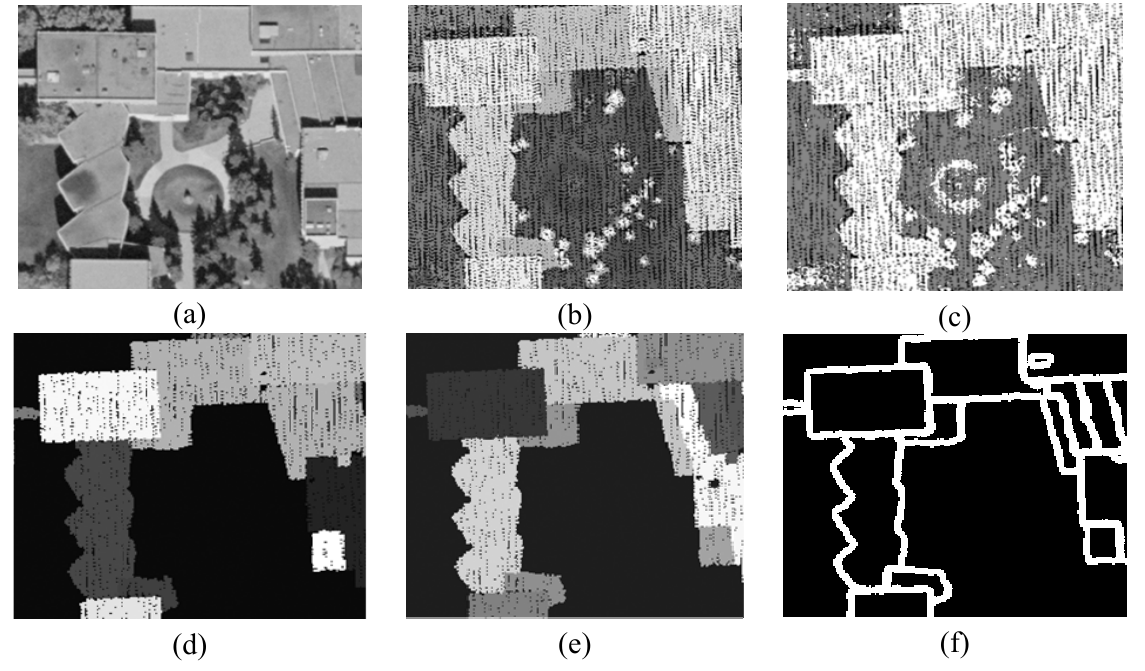
Figure 2. A dataset with complex and connected structures: (a) aerial photo; (b) LiDAR data; (c) classified terrain and off-terrain points; (d) generated building hypotheses; (e) building primitives; and (f) initial boundaries of the building